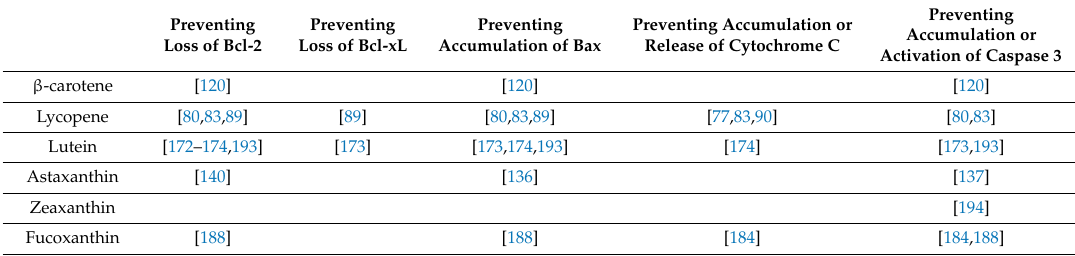
Table 1. Current studies investigating roles of carotenoids in apoptotic pathways of brain related